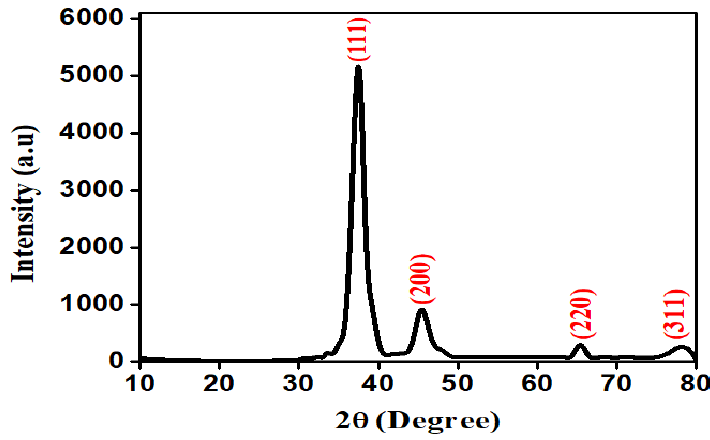
Figure 3. XRD pattern of Ag NPs.